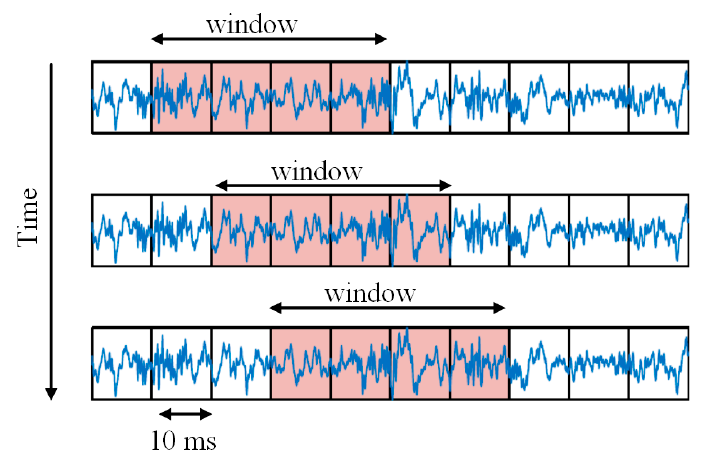
Figure 8. Feature extraction circuit.